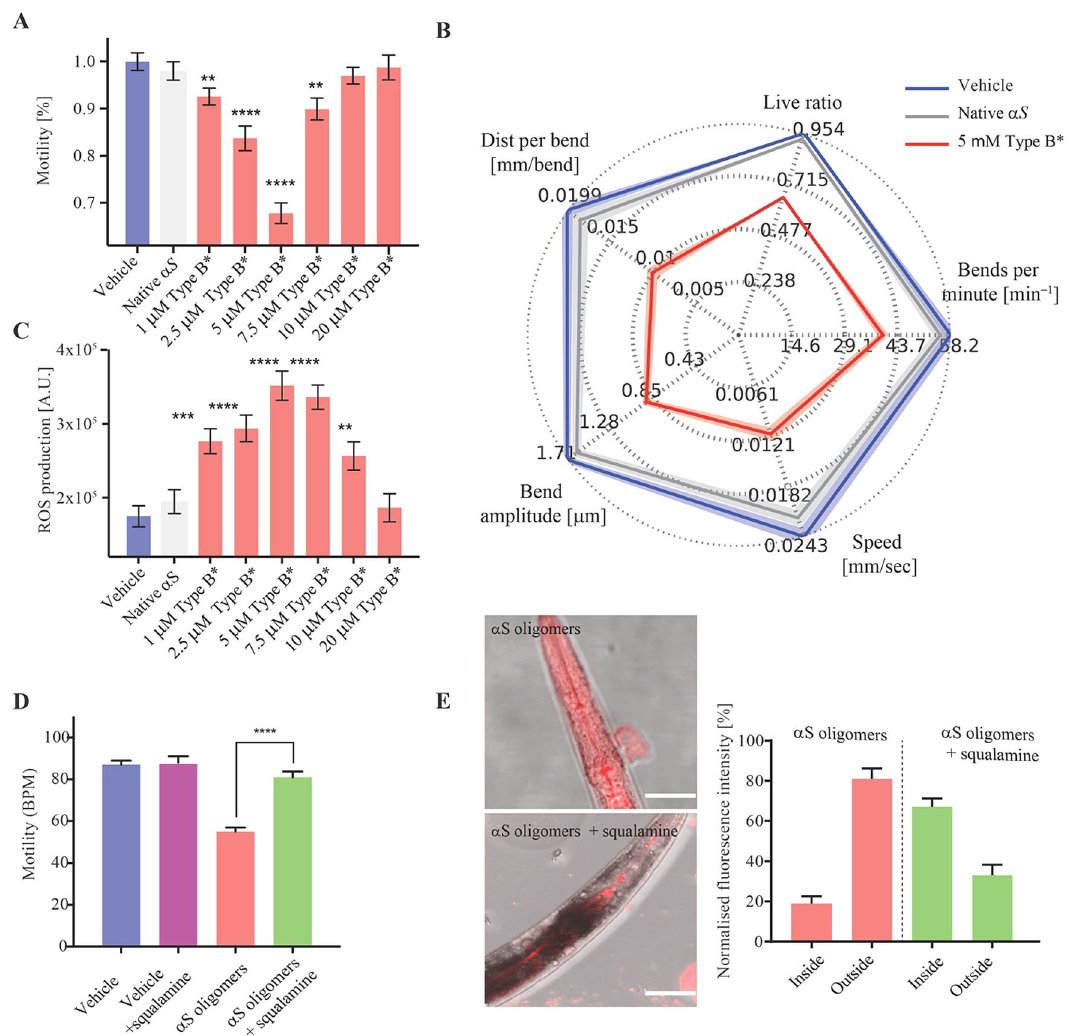
Figure 5. Effects of the exposure to type B α-synuclein oligomers on the worm fitness. ( A ) Worms were exposed at day 0 (D0) of adulthood to type B α-synuclein (αS) oligomers 23,24 at 1, 2.5, 5, 7.5, 10 and 20 μM (monomer equivalents), the motility is normalized to the value of the vehicle. 600 worms were analyzed after 6 h exposure per condition. Bars indicate mean and SEM values. One experiment representative of three, which showed similar results, is shown. Statistical tests (Student’s t test) were carried out using Graph- pad prism. The double (**), triple (***) and quadruple (****) asterisks indicate P ≤ 0.01, 0.001 and 0.0001, respectively, relative to unexposed worms. ( B ) High resolution phenotypical fingerprinting carried out using the wide field of view nematode tracking platform (WF-NTP, colors as in ( A ). Multiple fitness readouts (speed, bends per minute, bend magnitude, distance per bend and live ratio) are reported. Up to 1200 animals per condition were analyzed. Thick coloured lines indicate mean and SEM values. ( C ) ROS production in worms exposed at day 0 (D0) to α-synuclein oligomers at 1, 2.5, 5, 7.5, 10 and 20 μM (monomer equivalents). Bars indicate the means and SEM values. ( D ) Quantification of the worm behavior after exposure at D0 to 2.5 µM α-synuclein oligomers without or with 10 µM squalamine. Bars indicate mean and SEM values. Approximately 600 worms were analysed after incubation for 6 h. ( E ) Confocal microscopy images of worms exposed at D0 with 2.5 μM α-synuclein oligomers labeled with 5-FITC (right) or without (left) 12.5 µM squalamine at a α-synuclein:squalamine molar ratio of 1:5. The images were taken after 12 h of incubation. Horizontal bars indicate 80